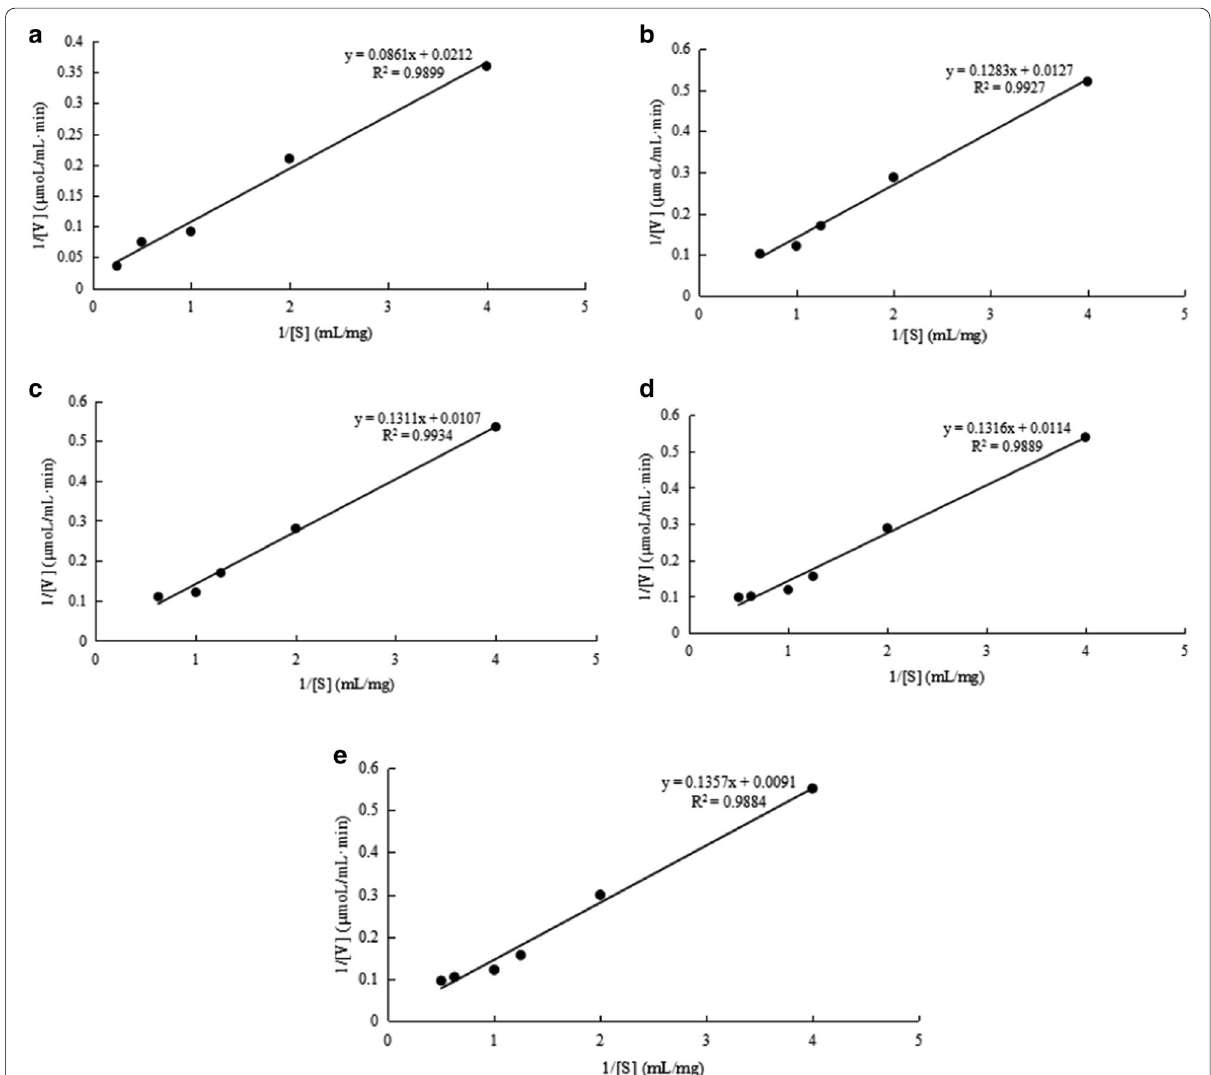
Fig. 5 Kinetic parameters of Amy2587 with different substrates. a Amylase activity; b Agarase activity; c Carrageenase activity; d Cellulase activity; e Alginate lyase